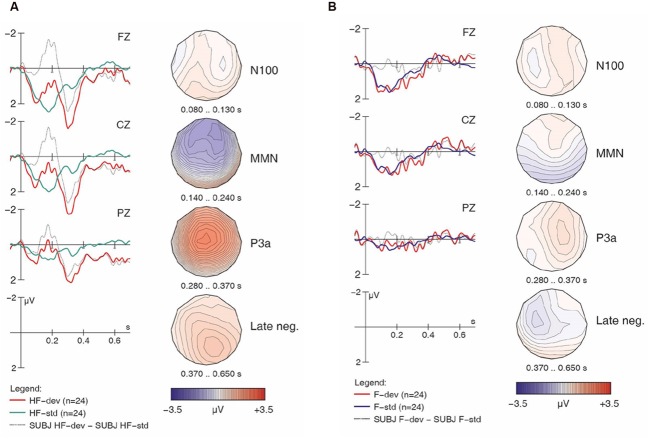
Native English responses to [hf] (A) and [f] (B) items, contrasting standards and deviants, with difference wave (deviant minus standard). Negativity is plotted upward.